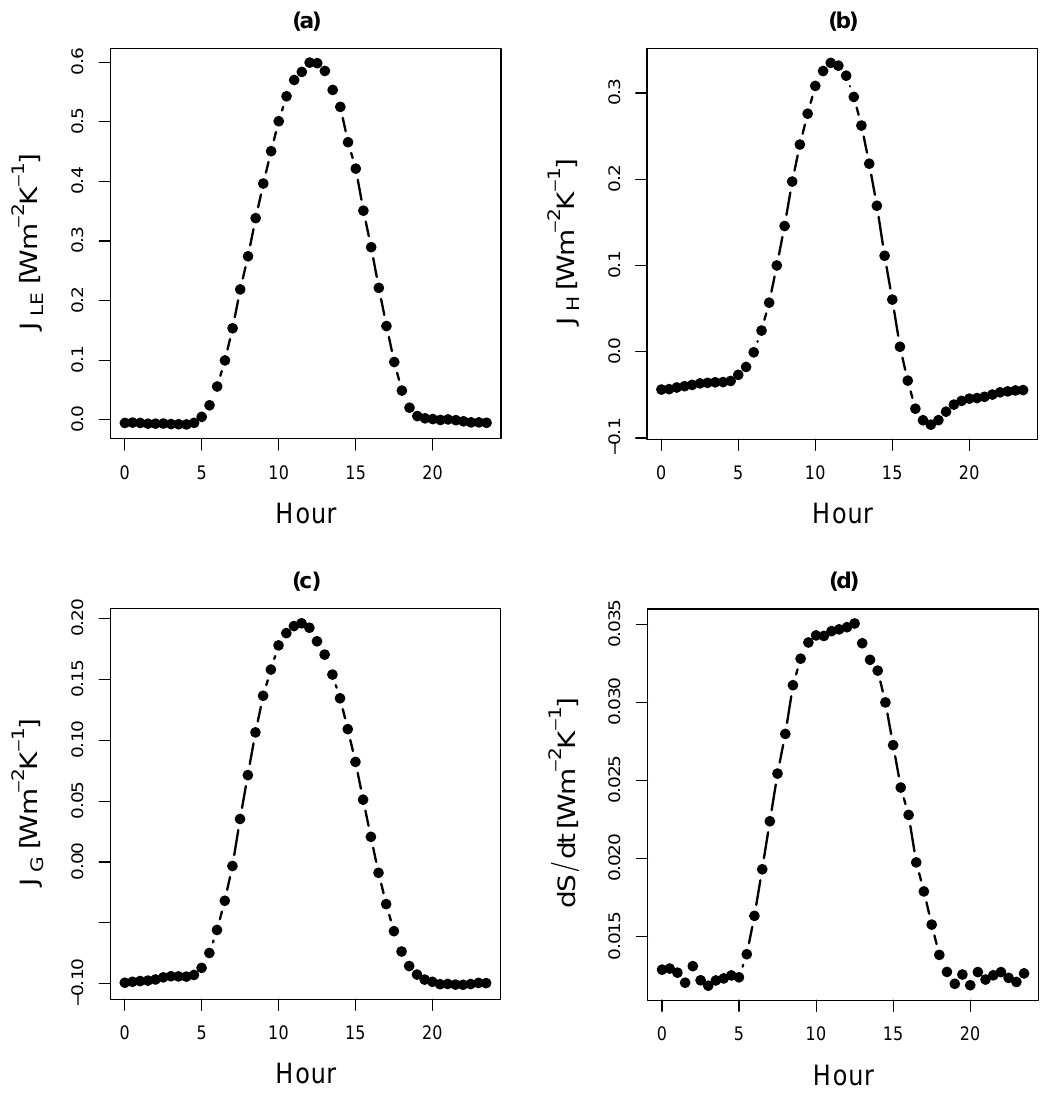
Fig. 4. Mean diurnal entropy terms associated with (a) transfer due to latent heat flux (b) transfer due to sensible heat flux (c) transfer due to soil heat flux and (d) the overall entropy